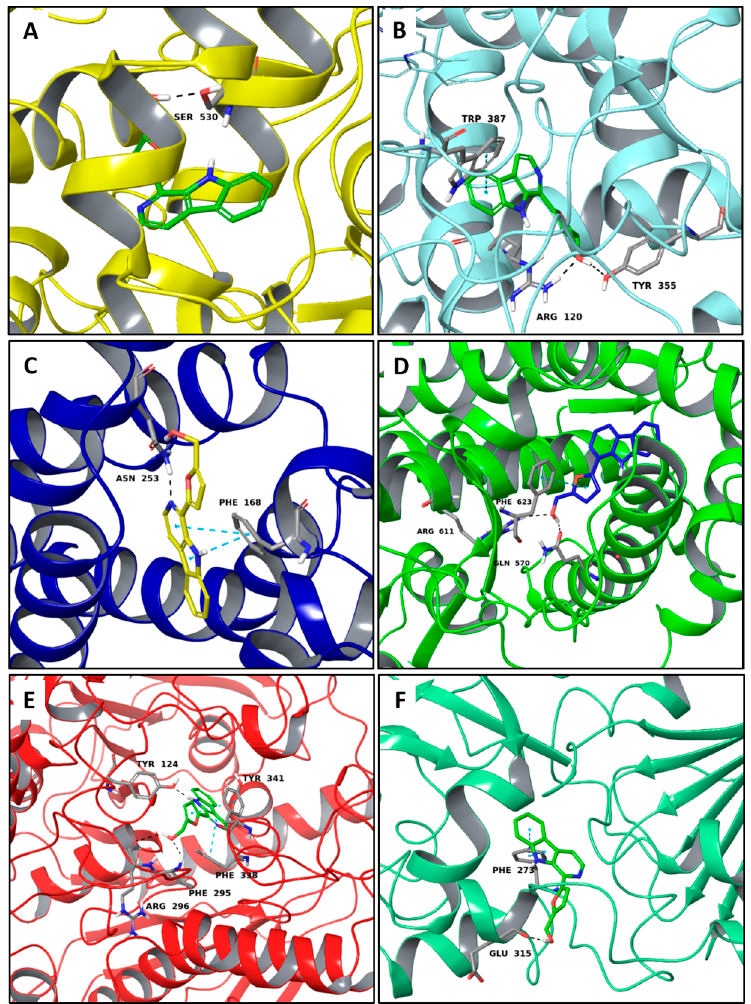
Figure 10. Molecular interactions between perlolyrine, the best non-selective MTA, and its best targets: ( A ) The protein target, COX-1 (PDB: 1Q4G). Protein is shown as a yellow cartoon while ligand is shown as green carbon sticks; ( B ) Protein target: COX-2 (PDB: 5IKR). Protein is shown as a turquoise cartoon while ligand is shown as green carbon sticks; ( C ) Protein target: adenosineA2A receptor (PDB: 3RFM). Protein is shown as a dark blue cartoon while ligand is shown as yellow carbon sticks; ( D ) Protein target: glucocorticoid receptor (PDB: 1M2Z). Protein is shown as a florescent green cartoon while ligand is shown as dark blue carbon sticks; ( E ) Protein target: AChE (PDB: 4EY7). Protein is shown as a red cartoon while ligand is represented as green carbon sticks; ( F ) Protein target: SIRT1 (PDB: 4I5I). Protein is shown as an aquamarine cartoon while ligand is shown as green carbon sticks. H-bonds and π - π interactions are shown as dashed black and cyan lines respectively. Amino acid residues involved in the interactions are shown as gray sticks.